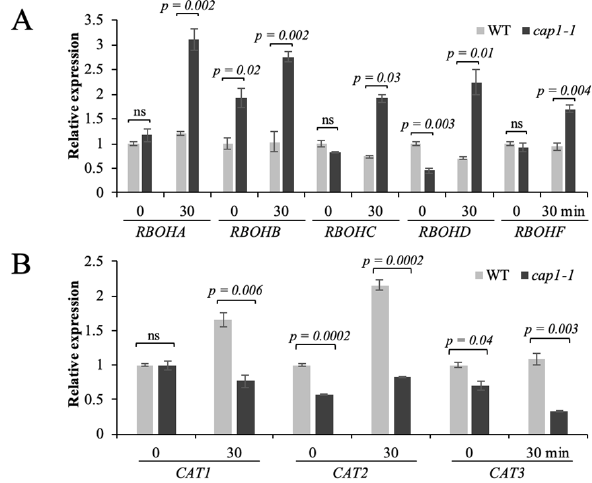
Figure 5. The expression of NADPH oxidase and CAT genes in WT and cap1-1 plants to NH 4+ treatment. ( A ) Relative transcript levels for RBOHA , RBOHB , RBOHC , RBOHD , and RBOHF , ( B ) and CAT genes ( CAT1 , CAT2 , and CAT3 ) in WT and cap1-1 plants under 3 mM NH 4 Cl treatment for 0 and 30 min quantified by qRT-PCR. Five-day-old plants grown on MS medium were transferred to MS NH 4+ -free medium for 2 days, then treated with 3 mM NH 4 Cl. The value for each gene in the WT at 0 min was set as 1. Data are presented as means ± SE of three replicates (independent samples t -test; p < 0.05; ns, not significant).